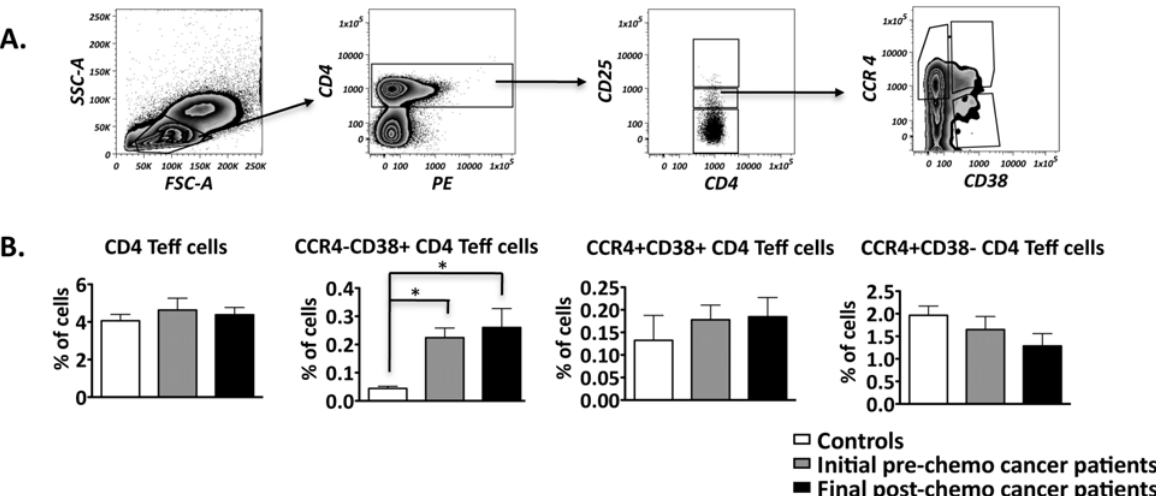
Figure 5. Frequency of CD4+ effector T cell subsets present within the PBMCs of patients. ( A ) The gating strategy employed to identify the different CD4+ T cell subsets present in the PBMCs; ( B ) Comparison of CD4+ T cell subset frequencies between healthy controls (n = 5) and ovarian cancer patients undergoing chemotherapy (n = 5); ( C ) Frequency fluctuations of CD4+ T cell subsets of patients over the course of chemotherapy. The dotted line represents the mean frequency of the healthy controls. Comparison of T cell subset frequencies between controls and patients: * p <